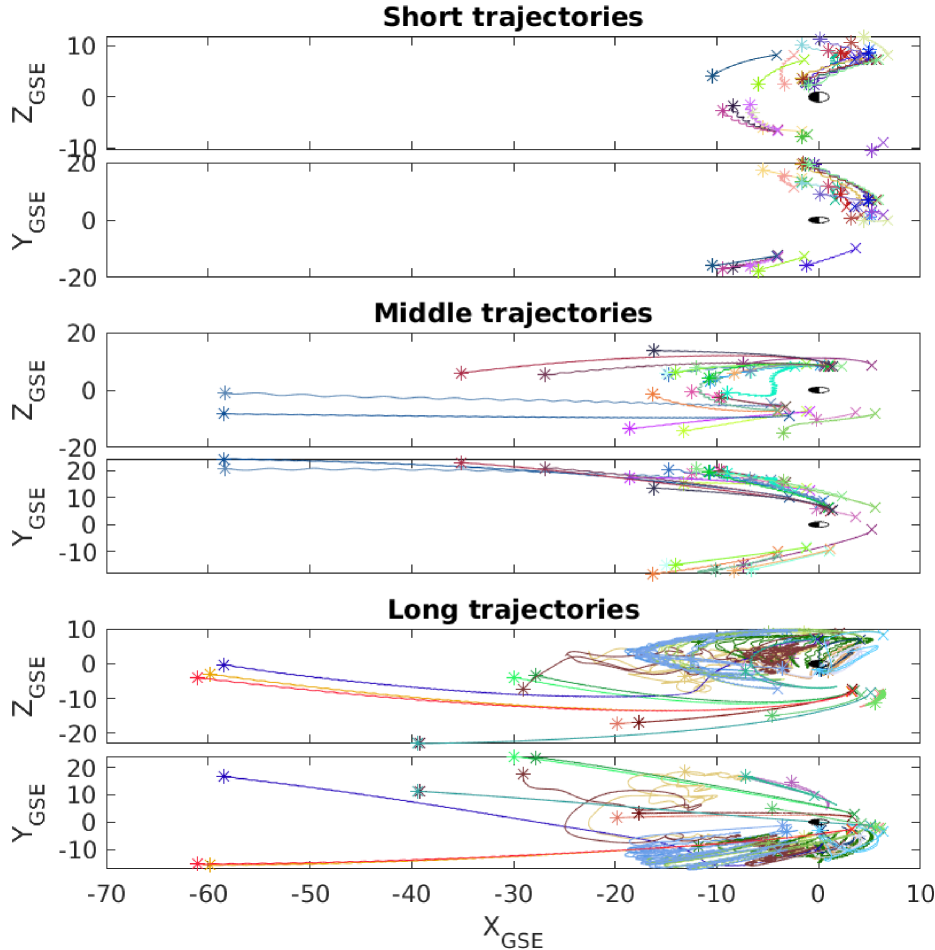
Figure 4. Sample of 25 short, middle, and long trajectories in the XZ and XY planes. Units of the axes are in Re. Each colour represents one trajectory, and the crosses and the asterisks show the initial and final position respectively.